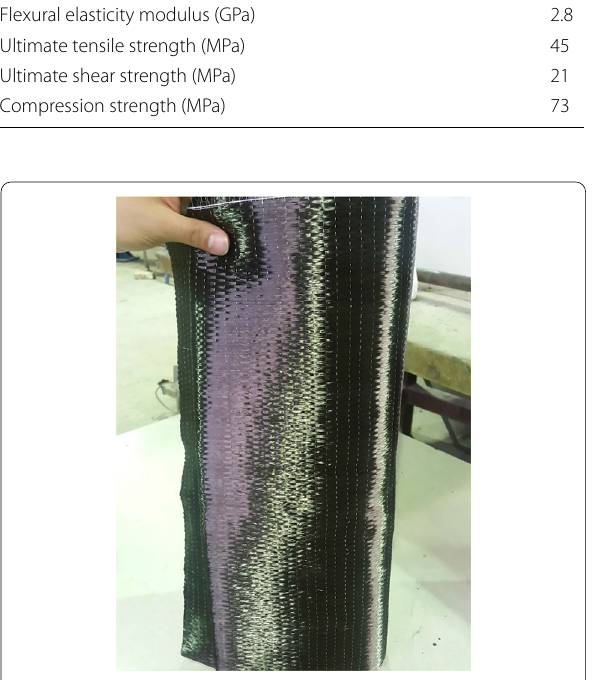
Fig. 1 CFRP sheets for strengthening.